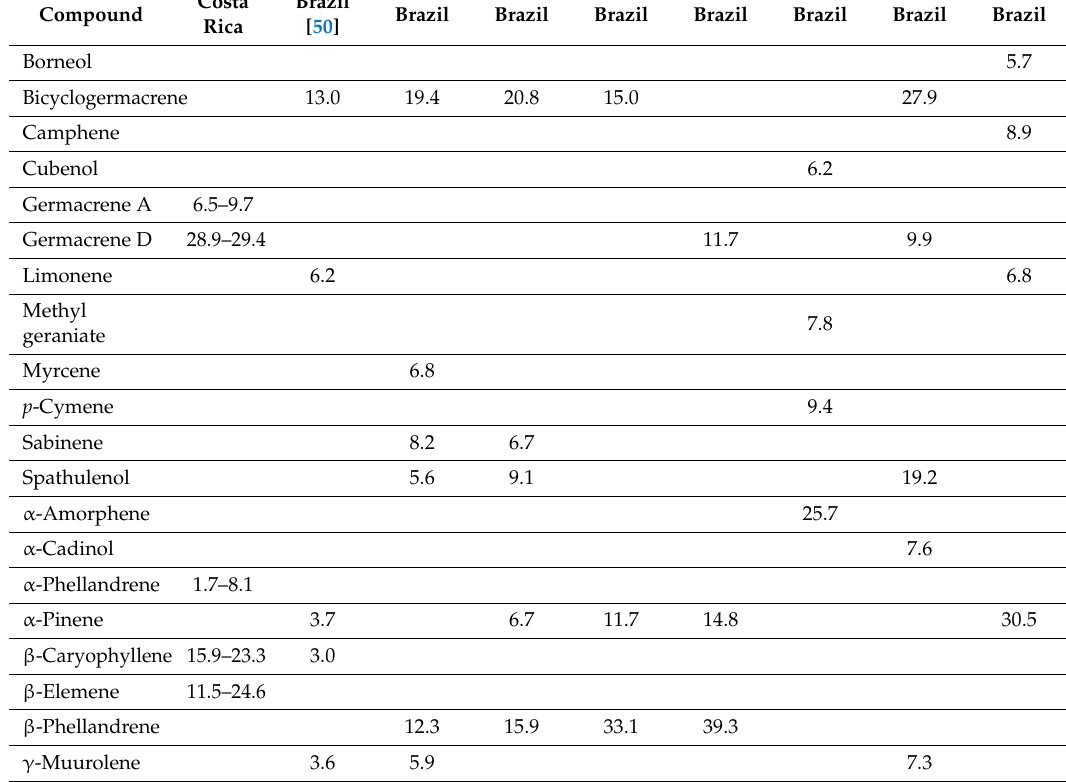
Table 6. Chemical compositions (%) of Piper amalago leaf essential